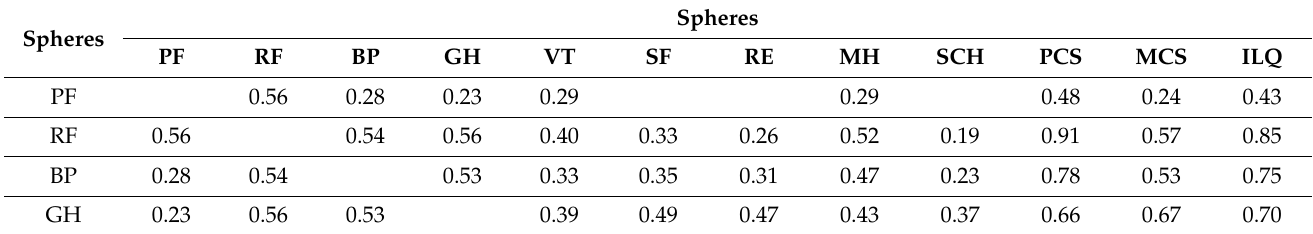
Table A4. Correlations of SF-36 spheres for the age group of 76–80 years (Spearman’s r